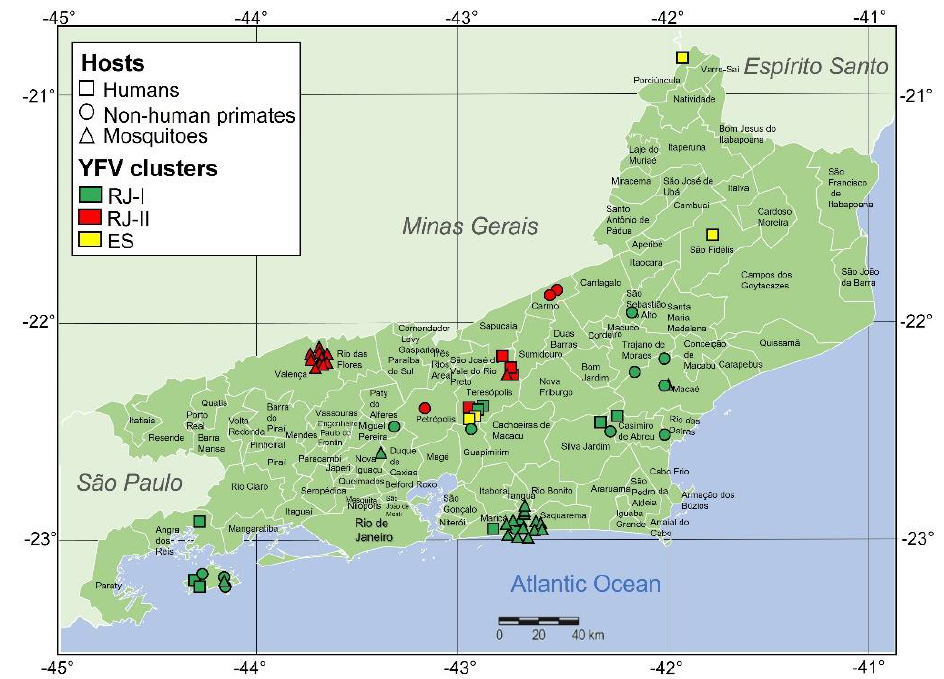
Figure 3. Spatial distribution of YFV samples of the 2017–2019 outbreak from 15 Rio de Janeiro state municipalities. YFV sequences form the YFV RJ-I clade from sites drained by the Macaé conjugated river basin (Macaé, Maricá, Miguel Pereira, Nova Iguaçú, Angra dos Reis, Teresópolis, Casimiro de Abreu, Silva Jardim, and Guapimirim). The YFV RJ-II clade, covering the conjugated river basins Paraíba do Sul, is formed by YFV sequences from Petrópolis, Teresópolis, Valença, and Carmo.